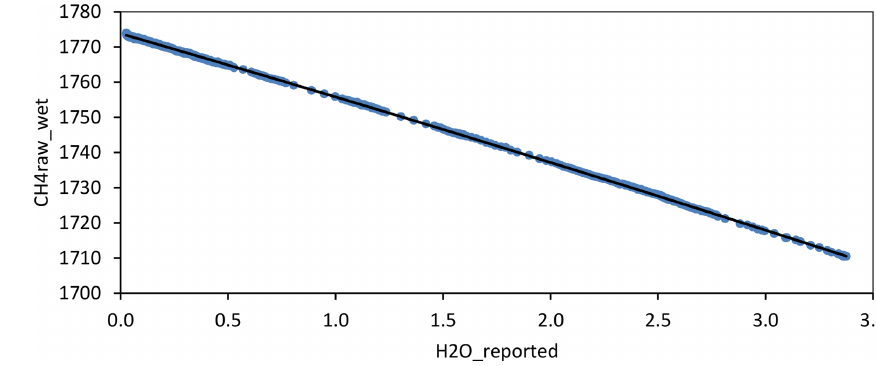
Figure 10. CH4raw_wet vs. hr during the water-droplet experiment (in blue) and the least-square fitted curve (in